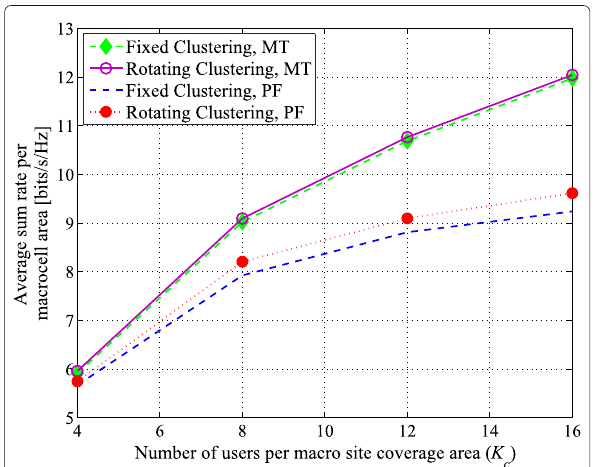
Fig. 6 Average achievable sum rate vs. K c over the area of a macrocell in an arbitrary cluster, comparing various T cl values for proposed rotating clustering scheme for six-cell layout, using simulated annealing scheduling with proportionally fair (PF) scheduling metric ( t c = 100) and SZF-DPC precoding; N macro = N pico = 2, M =